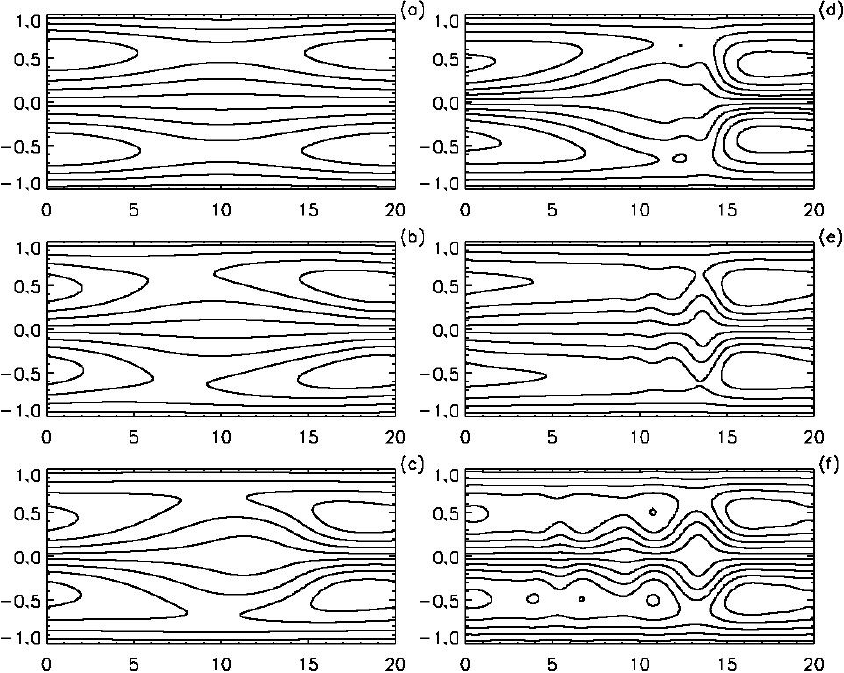
Fig. 2. Contour plots of the potential temperature field when initialized with our composite profile in a shallow domain chronologically ordered (a) to (f) . Non-dimensional times are 0, 34, 45, 88, 113,